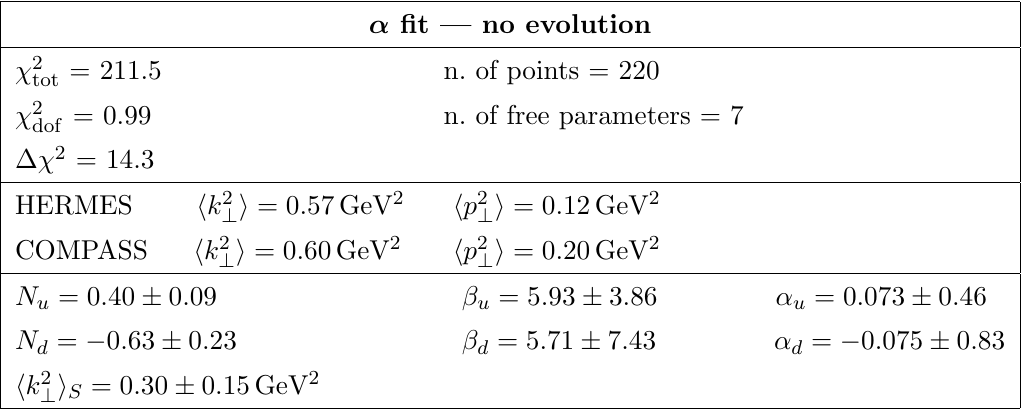
Table 3 . Best (cid:12)t parameters and (cid:31) 2 values corresponding to the (cid:11) -(cid:12)t. Notice that, despite the presence of two extra parameters w.r.t. the reference (cid:12)t presented in table 2, the value of (cid:31) 2